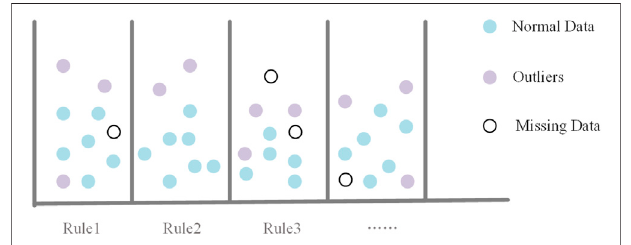
FIGURE 7 | The RBS with association rules.